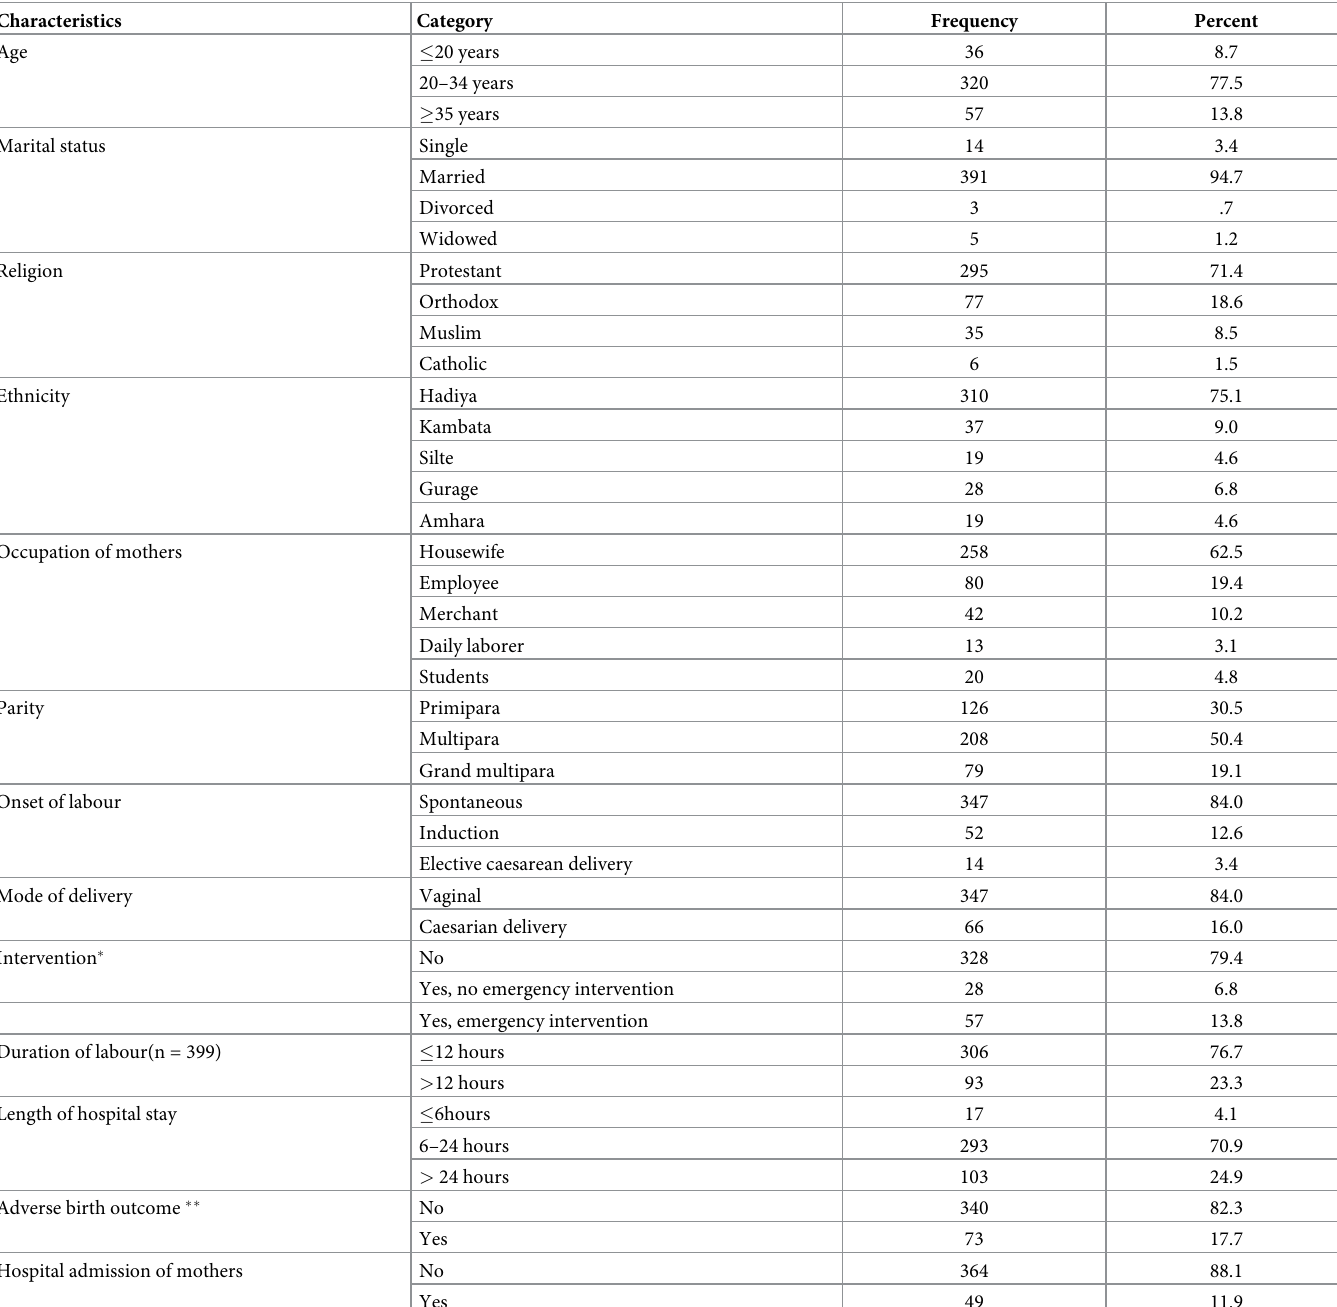
Table 1. Socio-demographic and obstetric characteristics of mothers who had given birth in the Hadiya zone public hospitals, July 2020 (n = 413).